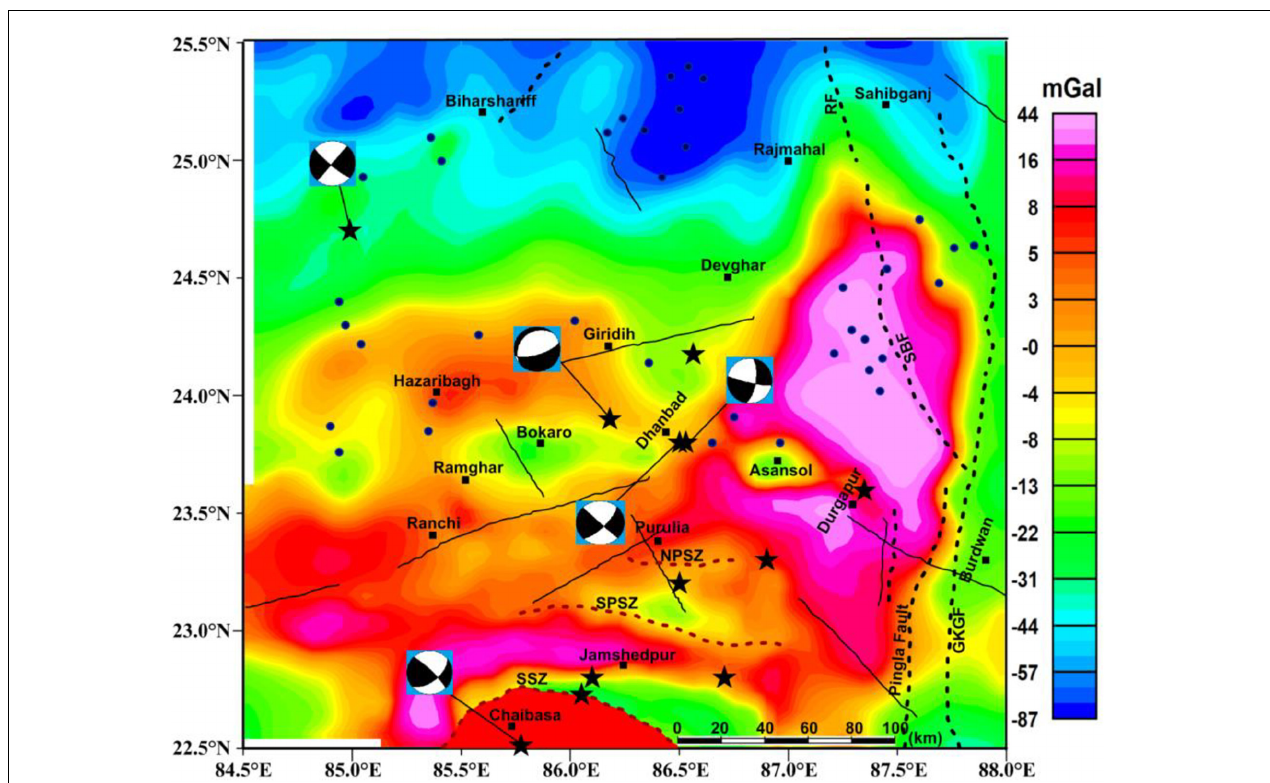
FIGURE 9 | Airy Isostatic anomaly map of the study area, generated by removing the gravity effect of topography and its root (Airy) from the Bouguer gravity anomaly. Dark blue solid circles represent the location of the hot springs (after Sankar et al., 1991). Black stars represent the location of local earthquakes with magnitude M > 2.0, and beach balls show the focal mechanisms of some